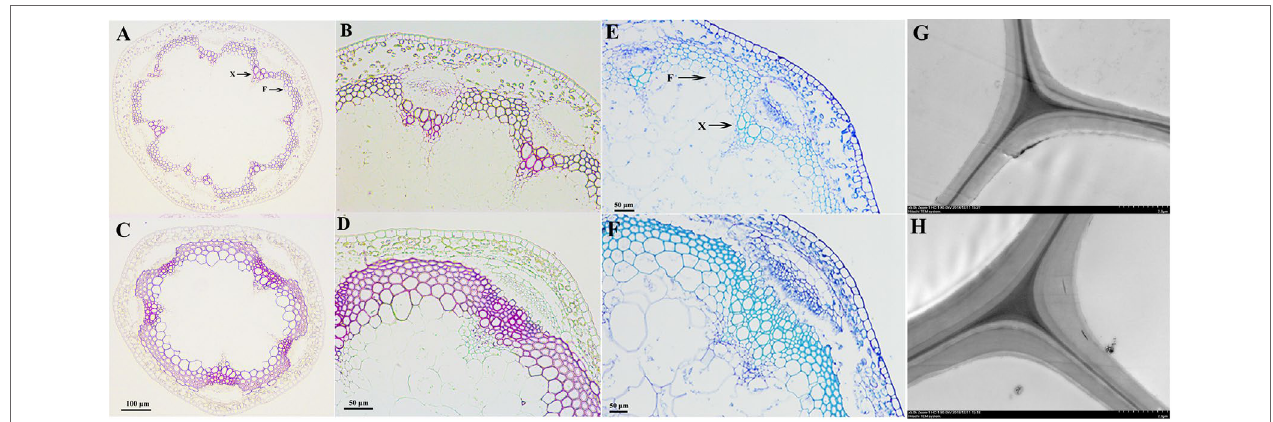
FIGURE 7 | Microscopic and ultramicroscopic observation of cell walls in the inflorescence stems of WT and PbBP -overexpressing transgenic lines. (A , B , E , and G) PbBP- overexpressing transgenic lines; (C , D , F , and H) wild-type Arabidopsis (WT); F: interfascicular fiber; X: xylem. (A , B , C , and D) Wiesner staining (lignin deposition patterns) of cross-sections of Arabidopsis inflorescence stem; (B and D) show higher magnification images of (A) and (C) , respectively. (E and F) Toluidine blue staining of the inflorescence stems from WT and transgenic lines; (G and H) TEM images of the ultrastructure of the cell